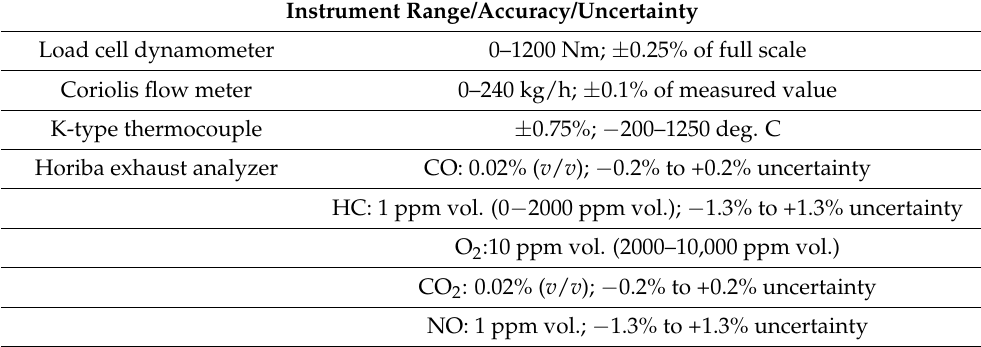
Table 5. Instrument Range/Accuracy.